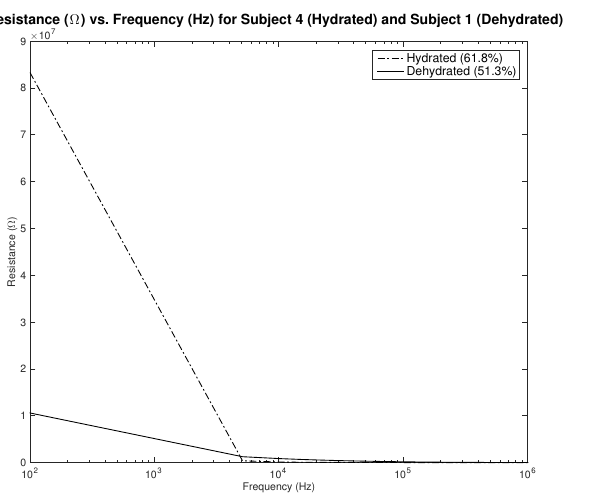
Figure 21. Testingresults—resistance( Ω )vs.